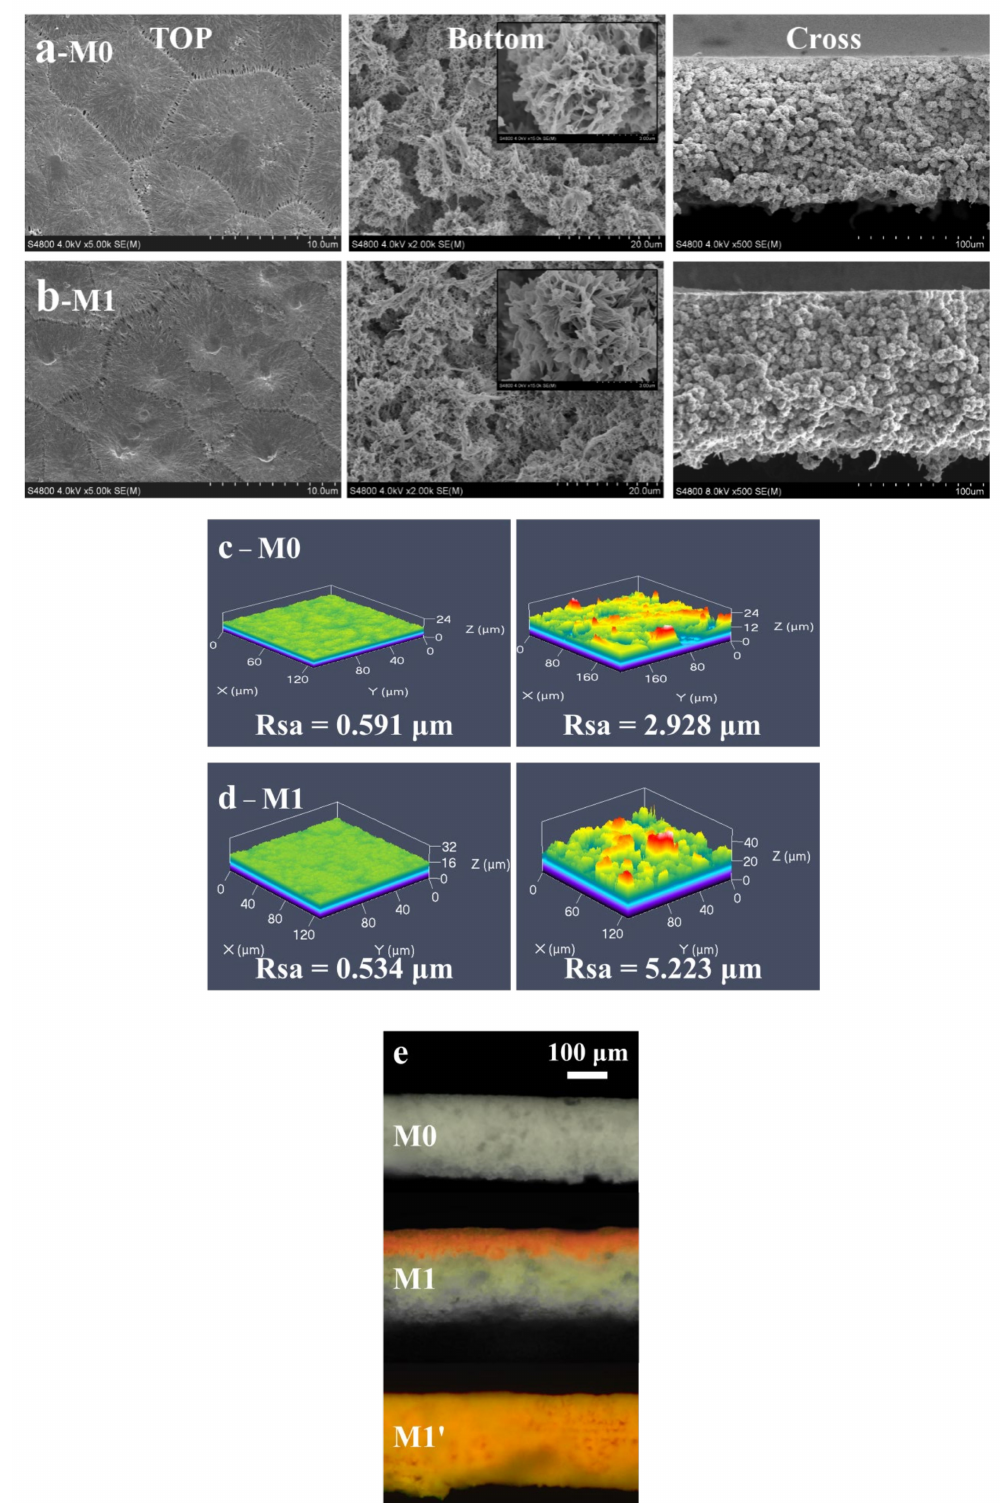
Figure 3. The morphological structure of membranes: ( a , b ) are the morphological structures of the top surface, bottom surface, and section surface of M0 and M1, respectively; ( c , d ) show the roughness of the top and bottom surfaces of M0 and M1, respectively; ( e ) displays the stained cross-section of M0, M1, M1 (cid:48) , and the red layer with a clear thickness is the hydrophilic